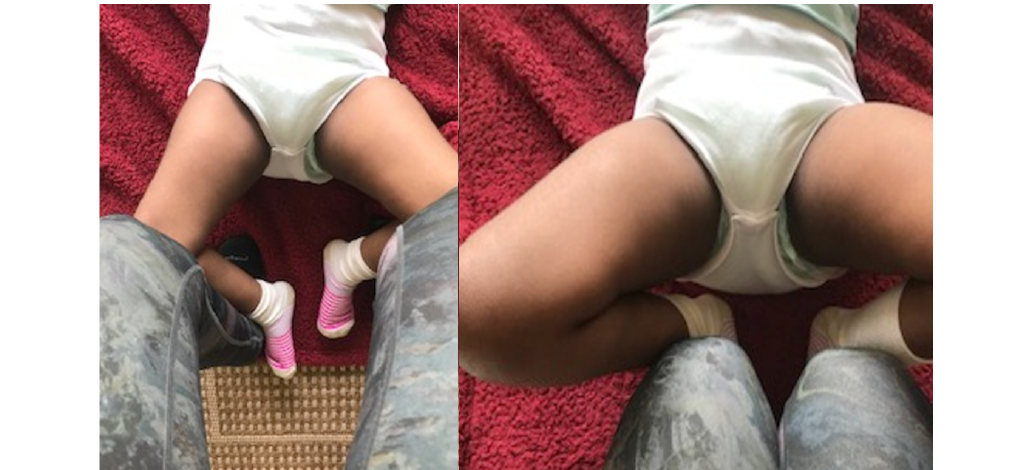
Figure 1. Left image was taken pre-IMES TX and the right image was taken post-IMES TX to the adductor muscles